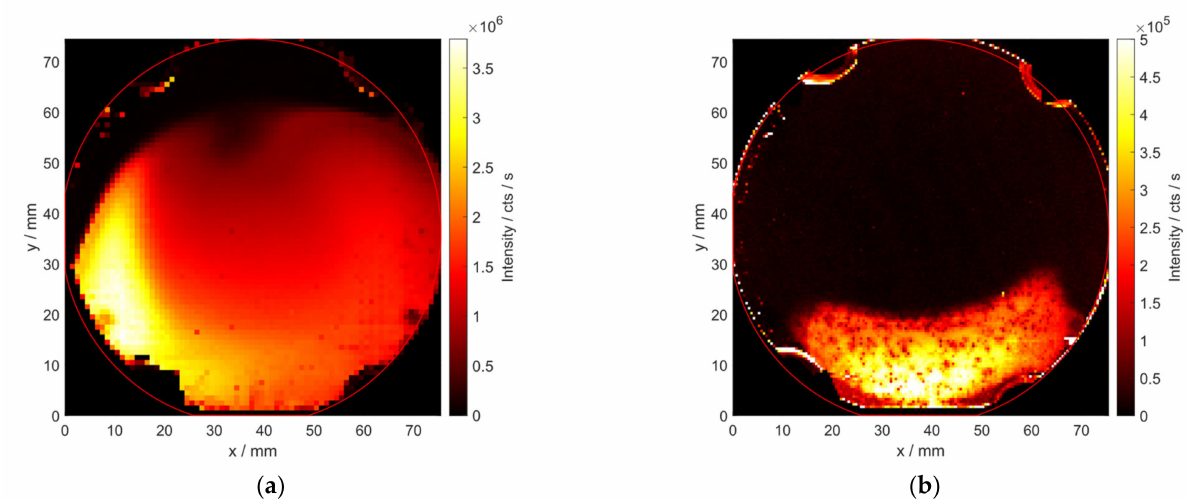
Figure A2. Integrated PL intensity maps (750–830 nm) of samples with low Al etch material. ( a ) 0.5 ML eq central Al shows a convex-shaped transition near 60 mm. ( b ) 0.3 ML eq central Al shows a concave-shaped transition near 20 mm.